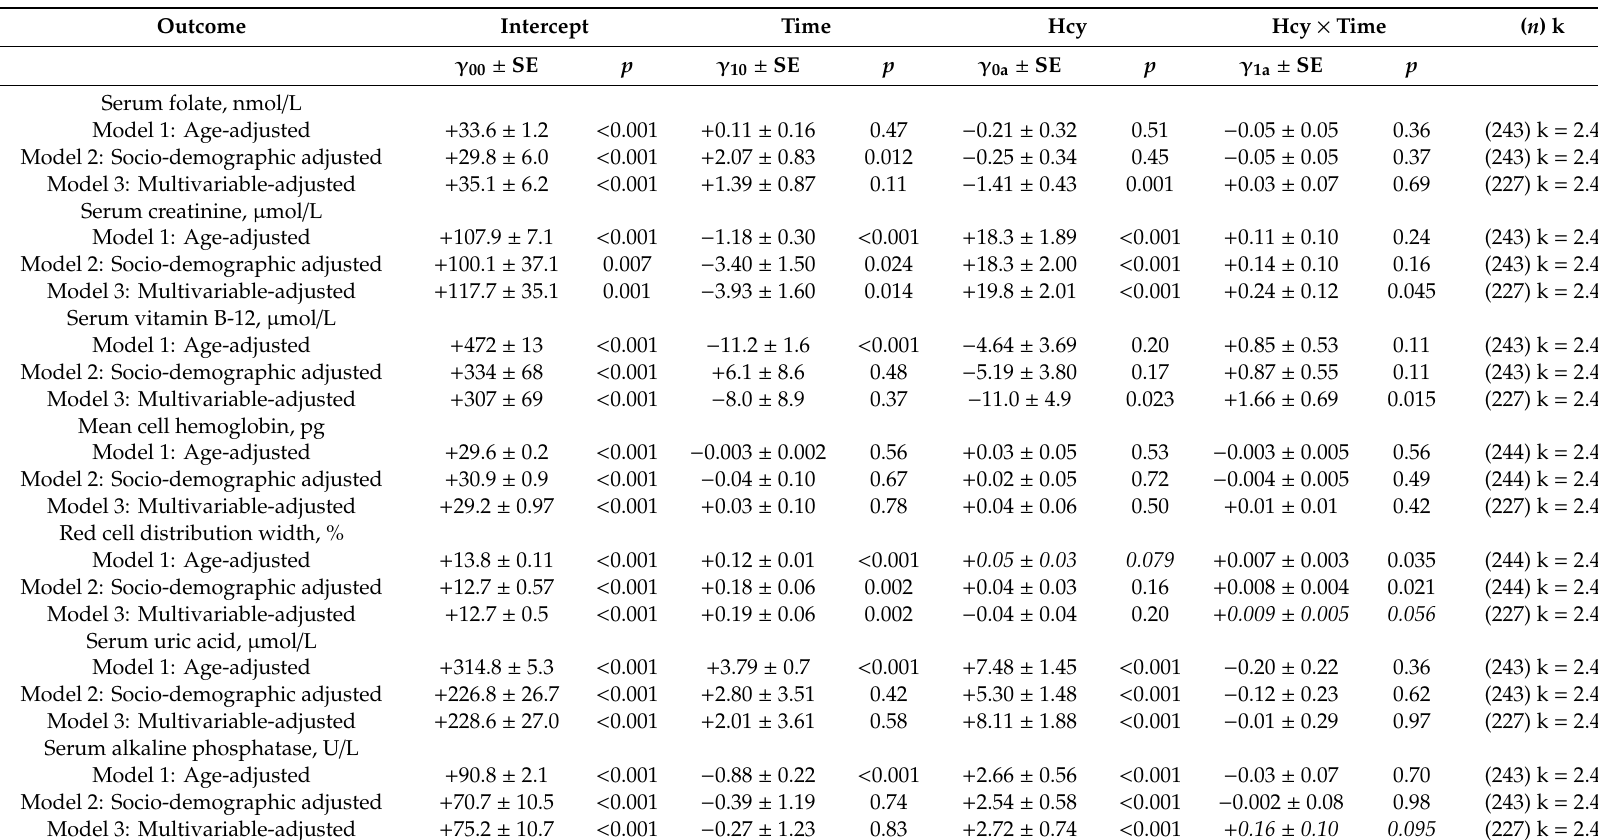
Table 3. Baseline serum homocysteine as a predictor of selected biochemical and hematological parameters at baseline and their change over time: mixed-e ff ects linear regression models; HANDLS 2004–2018 1